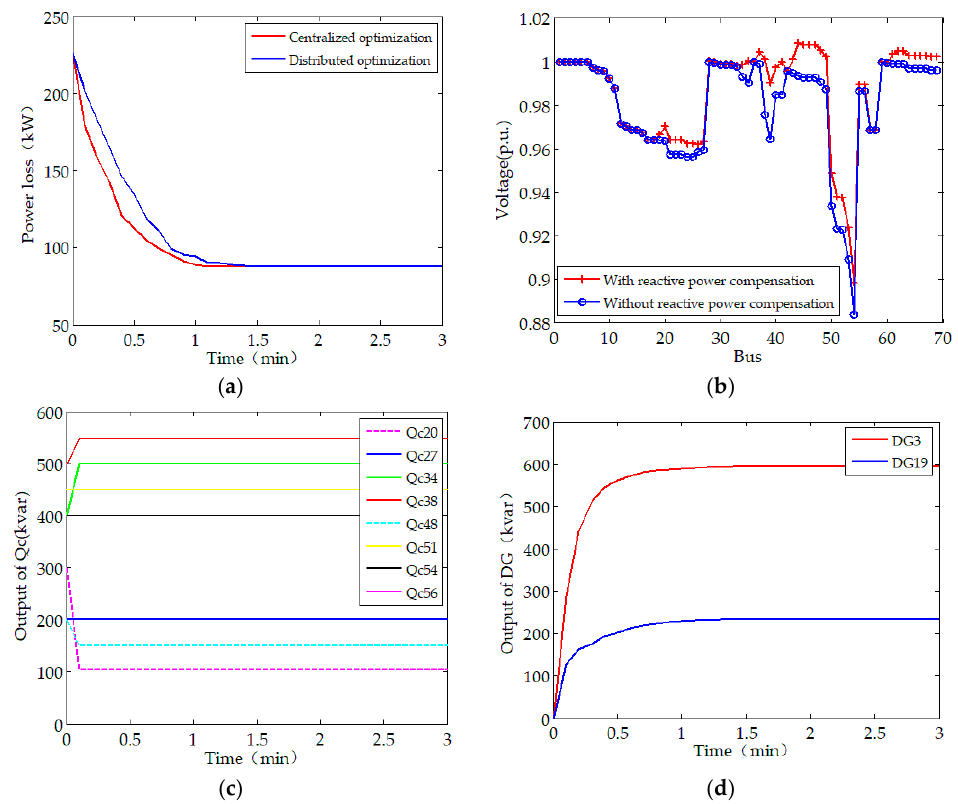
Figure 4. The optimal dispatch scheme under Scenario A: ( a ) Evolution of the objective function; ( b ) Voltage profiles with and without the distributed optimization solution; ( c ) Capacitor bank control sequences; ( d ) Output of Distributed Generators (DGs).